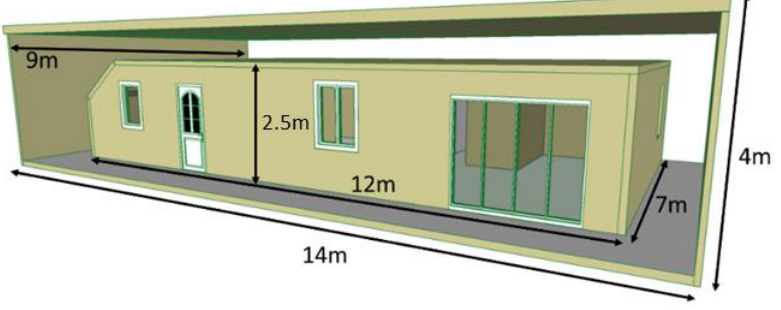
Figure 1. Illustration of the interior of the experimental facility.